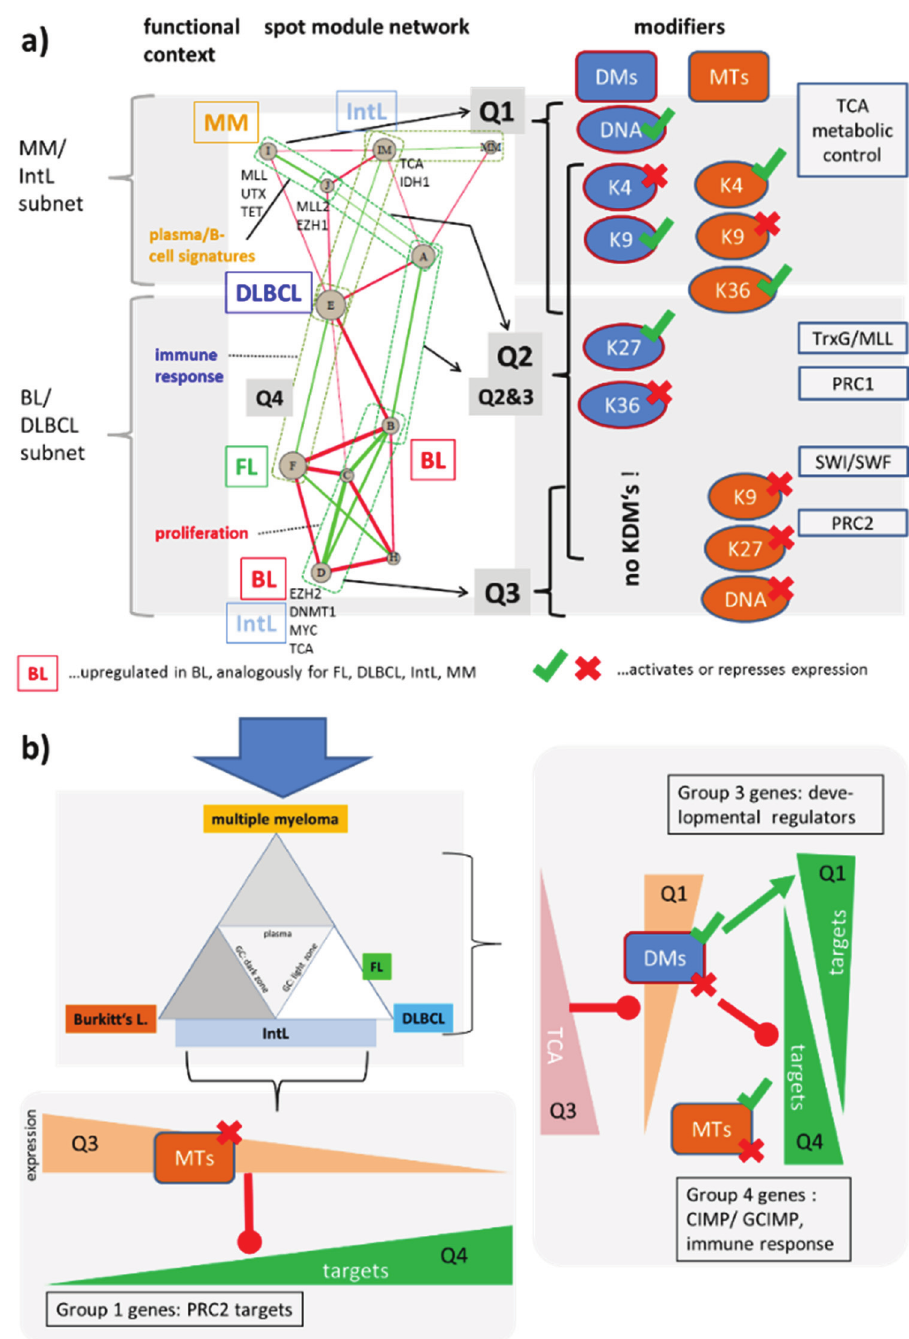
Figure 11. ( a ) Network of expression modules governing lymphoma heterogeneity. The nodes refer to the spot clusters extracted from the SOM analysis (for functional assignments see [6]). Green and red edges indicate positive and negative correlations with |w| > 0.3 using the weighted topological overlap correlation measure (see also Figure 2). A “backbone” of correlated modules can be assigned to the Q1–Q3 quadrants of the SOM used to map enzyme activities. Accumulation of different types of modifiers and complexes in Q1–Q3 is shown in the right part. Q4 is almost depleted from modifiers. A detailed list of the modifiers found in each spot is given in Figure S3. The network can be roughly divided into two subnets as described in the text. ( b ) The DLBCL/BL and MM/IntL subnets explain the expression changes of three different groups of genes identified in [6] (see